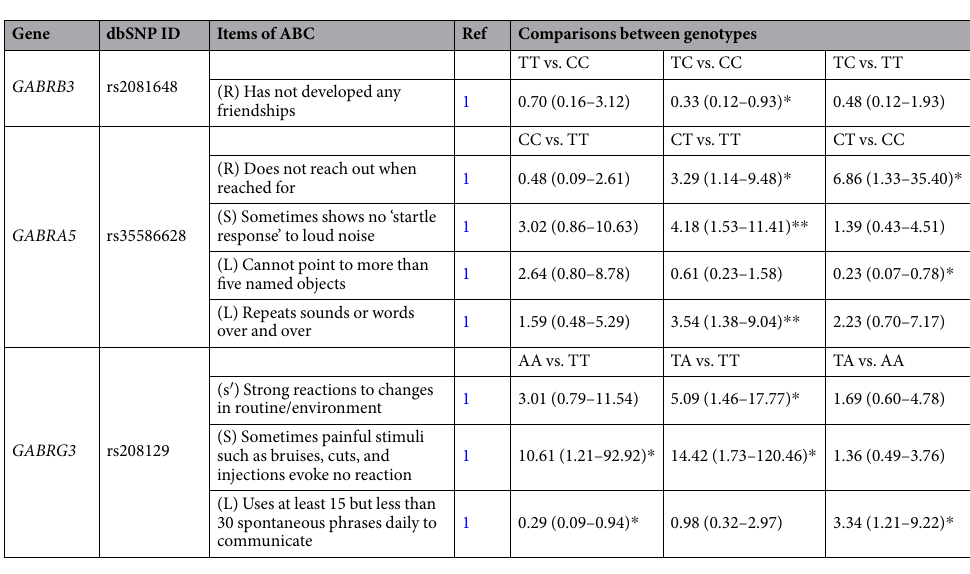
Table 4. Odds ratios (ORs) with 95% confidence intervals (CI) of existing relevant impairments in items of ABC among genotypes of GABRB3 SNP rs2081648, GABRA5 SNP rs35586628, and GABRG3 SNP rs208129 in ASD patients. Ratings in items of ABC with a two-point scale (0 = no; 1 = yes). The reference (Ref) rating is 1 in a binary logistic regression analysis (while adjusting for sex, age, and IQ). ASD patients for GABRB3 rs2081648: n = 14 TT, n = 44 TC, and n = 41 CC. ASD patients for GABRA5 rs35586628: n = 18 CC, n = 42 CT, and n = 39 TT. ASD patients for GABRG3 rs208129: n = 26 TT, n = 43 TA, and n = 30 AA. * p < 0.05; ** p < 0.01. ABC, Autism Behavior Checklist; ASD, autistic spectrum disorders; L, language; R, relating; S, sensory; s ′ , social and self-help; SNP, single-nucleotide polymorphism; Ref, reference; vs.,